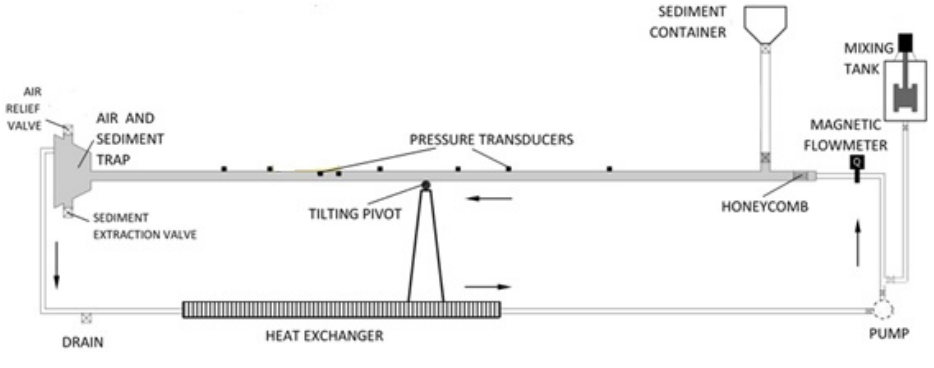
Figure 1. Sketch of the experimental setup.